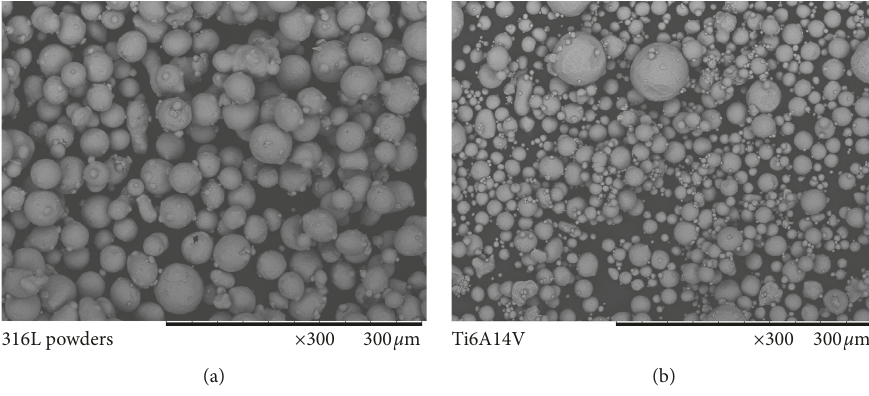
Figure 1: SEM micrographs of 316L and Ti6Al4V powders.